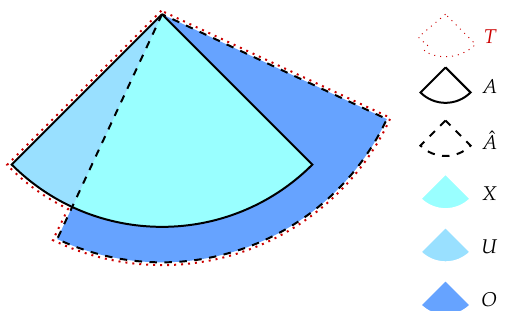
Figure 2. Schematic mass movement deposit distribution with superimposed simulation. A is the observed deposition area (reference situation), whereas ˆ A is the total simulated area. O is the size of the overestimated area, whereas U is the size of the underestimated area. X is the area in which the simulation outcome and the reference situation overlap. Finally, T refers to A ∪ ˆ A